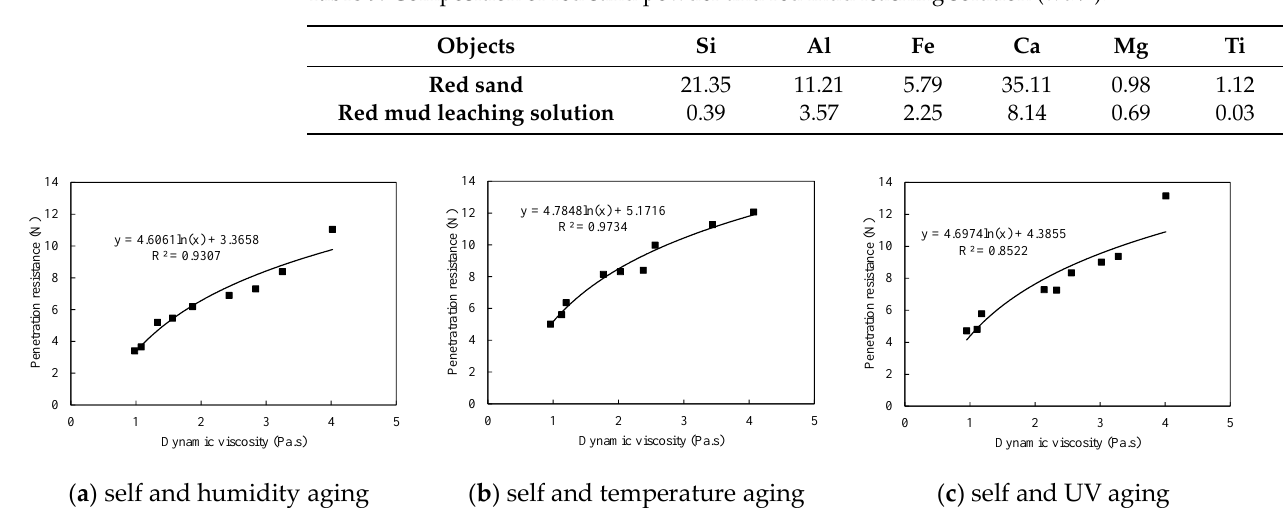
Table 9. Composition of red sand powder and red mud leaching solution (wt.%).